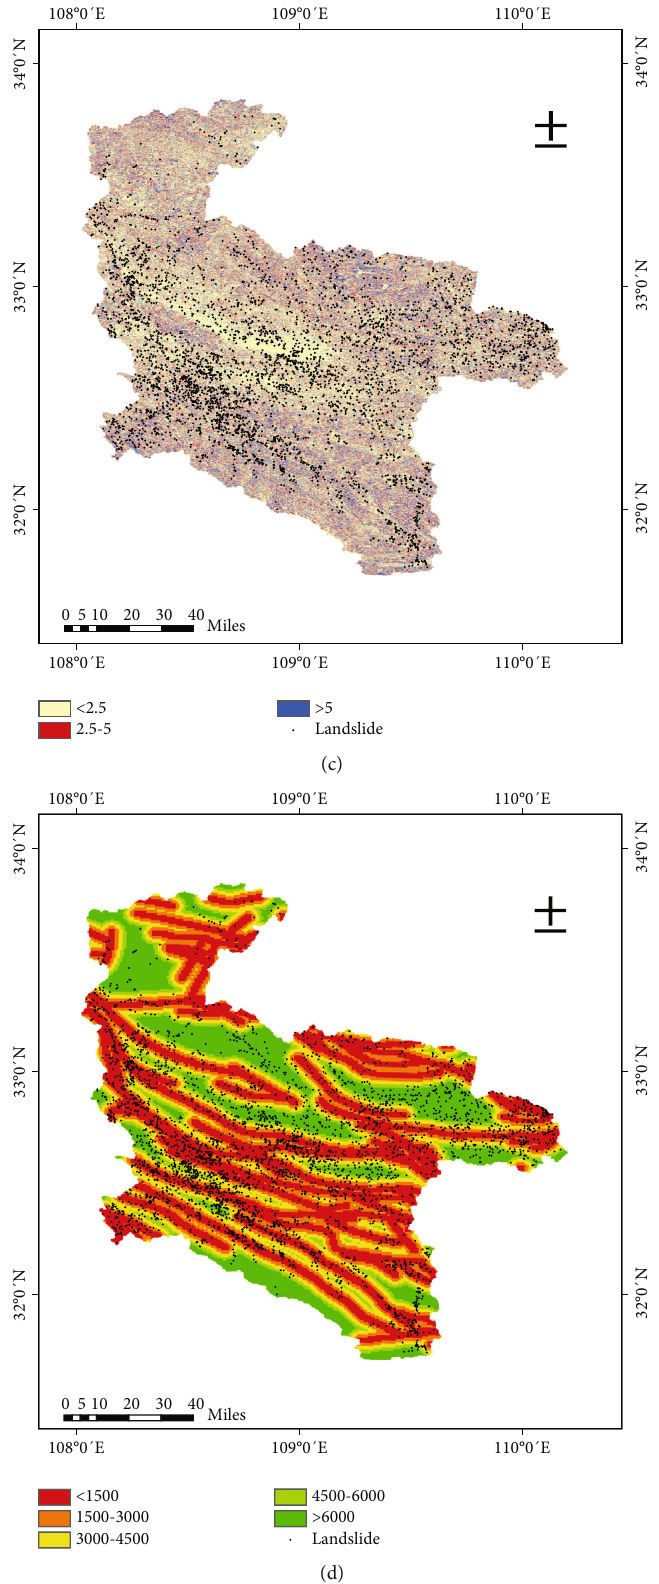
Figure 3: Geological and hydrogeological factors mapping of the study area: (a) rainfall; (b) distance to rivers; (c) stream power index; (d) distance to